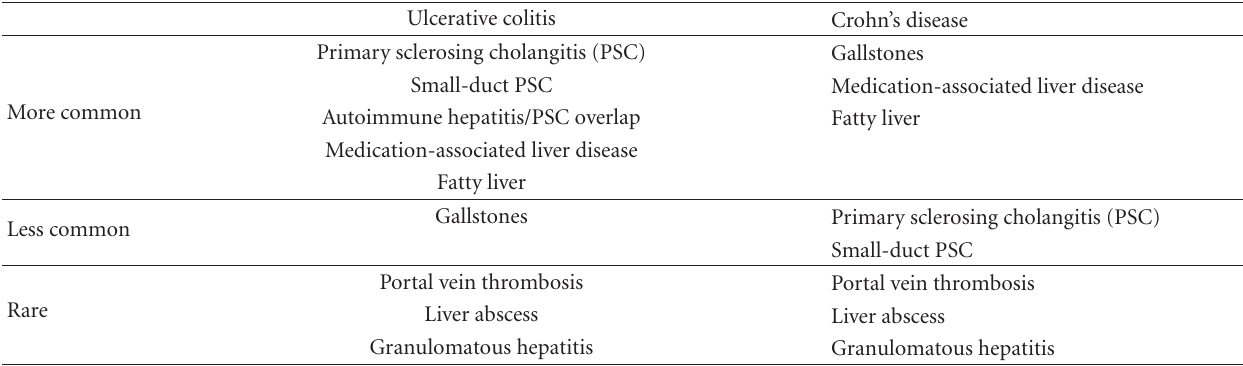
Table 1: Liver disorders in inflammatory bowel